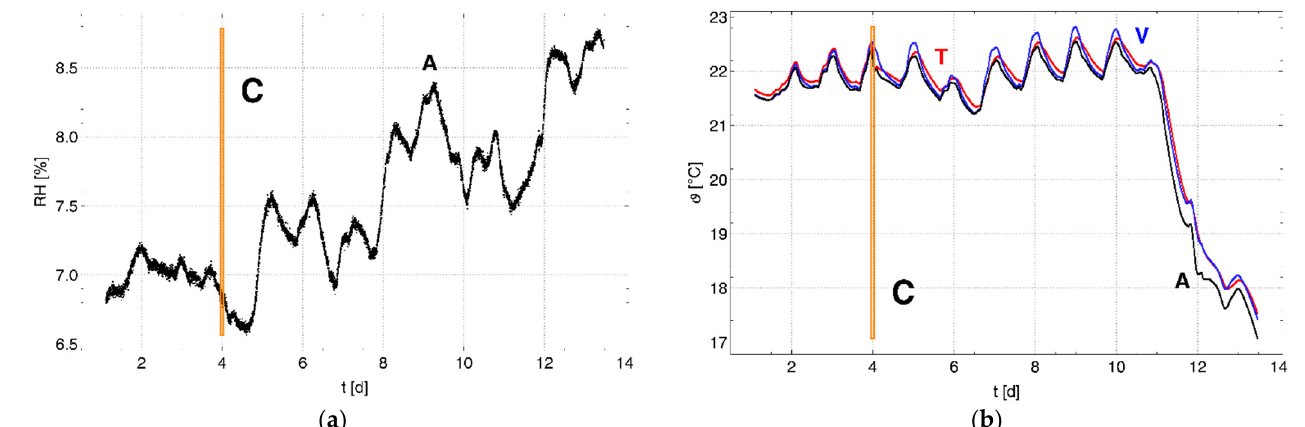
Figure A2. ( a ) Relative humidity in the air container and ( b ) temperatures in the containers (T: red, V: blue, A: black) of the test system. The orange box marked C indicates the change from Phase 1 to Phase 2.